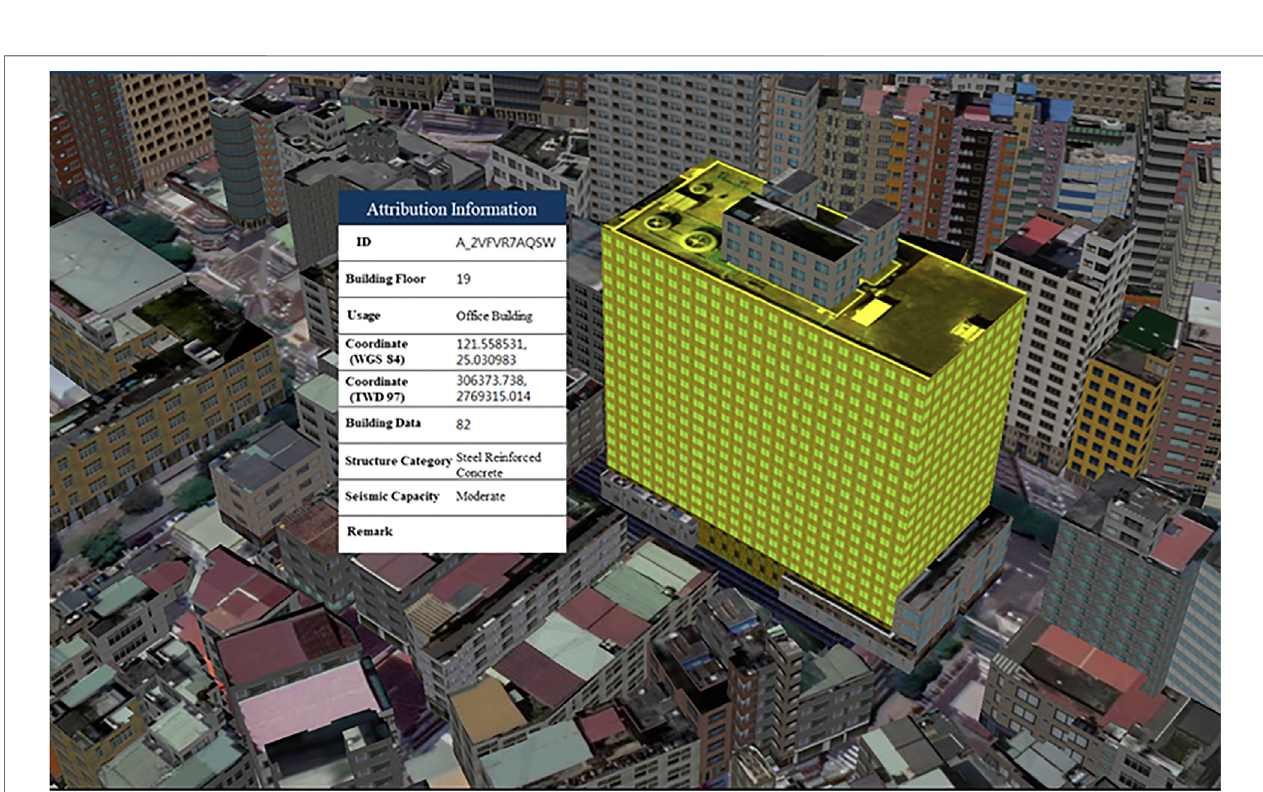
FIGURE 13 | Seismic attributes of a building in the 3D urban visualization.